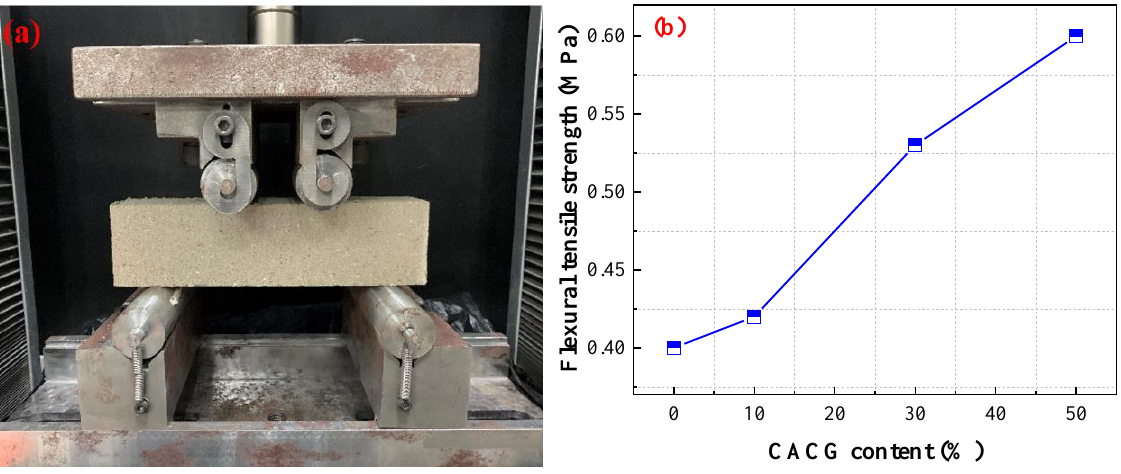
Figure 13. ( a ) Test device; ( b ) flexural tensile strength of specimens.